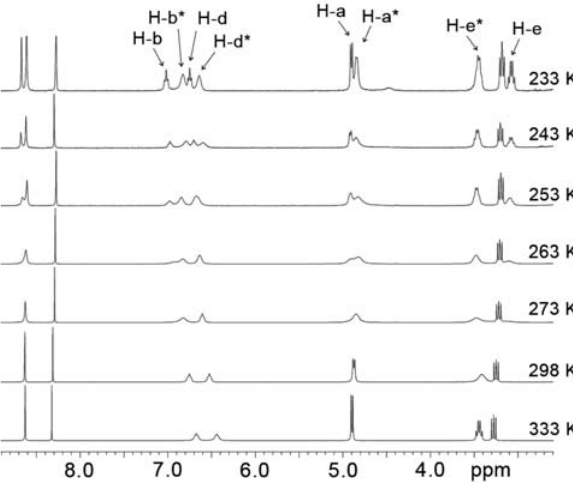
Figure 6. 1 H NMR spectra of 2 in acetonitrile- d re range from 233 to 333 K. Protons of the major species are deno- ted with asterisk